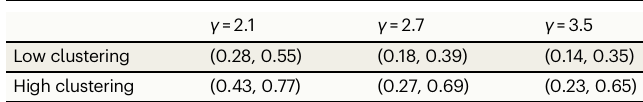
Table 1 | Intervals of C t for D = 1 used to evaluate confusion matrices for different regions of clustering and levels of heterogeneity γ =2.1 γ =2.7 γ =3.5